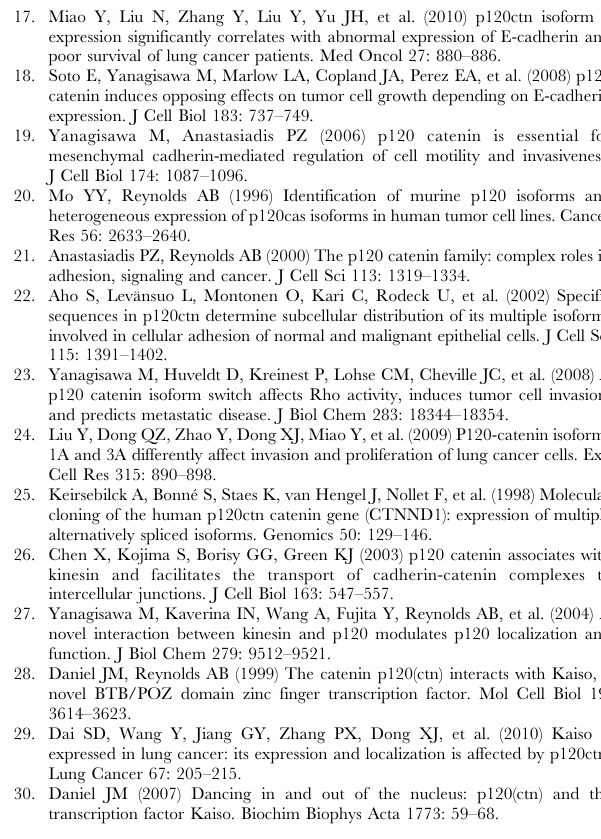
Table S1 Effects of p120ctn isoforms on level/subcellu- lar localization of E-cadherin and cell invasiveness in four cell lines. While p120ctn isoform 1A up-regulates E- cadherin expression in all 4 cell lines tested, its effect on cell invasiveness seems to be in two opposing directions, corresponding to the subcellular distribution of E-cadherin in each cell line. In cells with endogenous membranous expression of E-cadherin (HBE and H460), up-regulation of E-cadherin by p120 isoform 1A seems to suppress cell invasiveness, whereas, in those with endogenous cytoplasmic expression (SPC and LTE), it appears to enhance cell invasiveness. P120ctn isoform 3A enhances cell invasiveness with no significant alteration of E-cadherin expres- sion. Its effect on cell invasiveness seems to be independent of E- cadherin. *In comparison with the group transfected with vector alone. **In comparison with the group transfected with GFP-si-